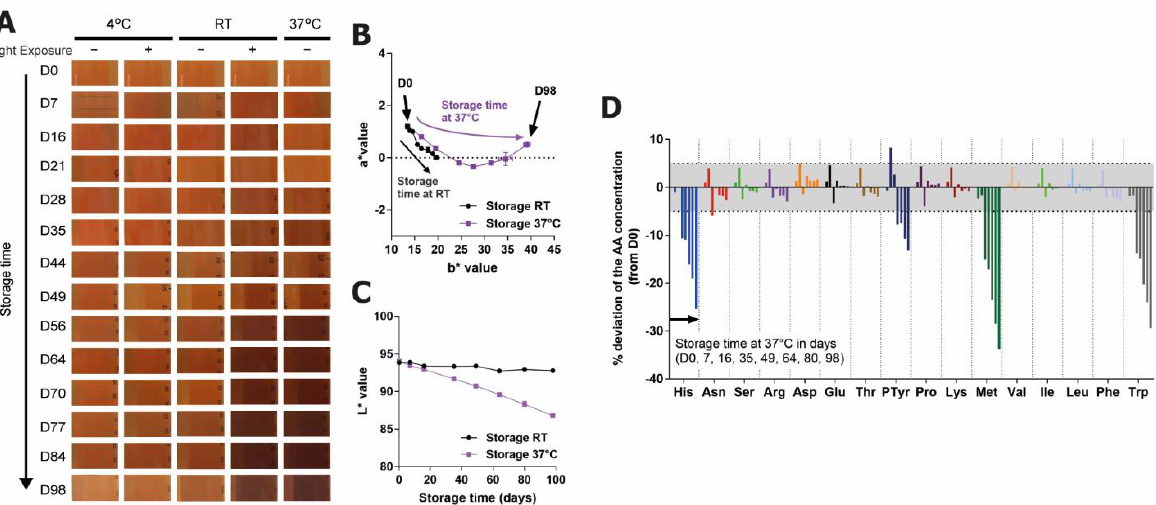
Figure 1. Discoloration and amino acid degradation of feed upon 98 days of storage in stressed conditions: ( A ) images of feed throughout the stability study; changes in ( B ) a* and b* values and ( C ) L* values of the RT and 37 °C stored samples (no light exposure); ( D ) changes in amino acid content of feed upon 37 ◦ C storage (no light exposure). Gray zones indicate the maximum variability due to the analytic